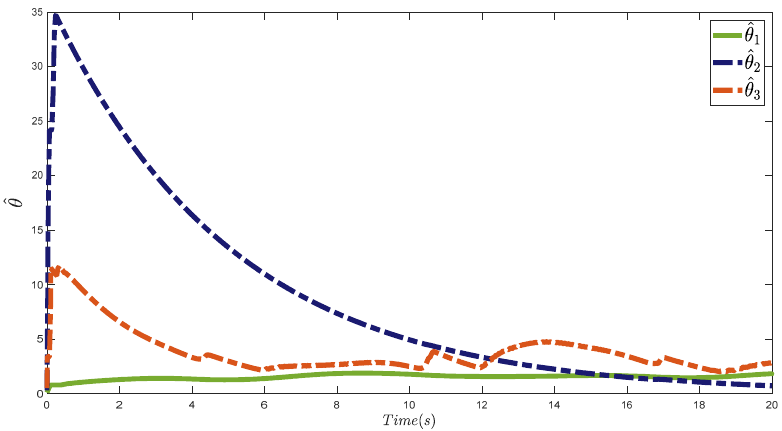
ˆ θ ˆ θ ˆ θ ˆ θ ˆ θ , 2 , 3 . , 3 .